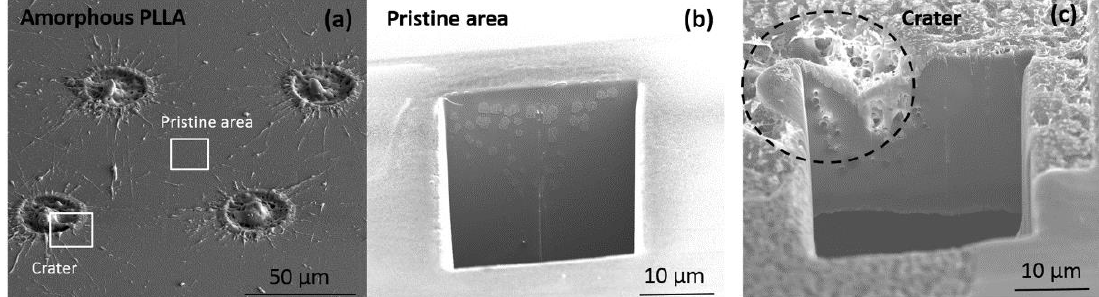
Figure 4. SEM images of craters produced by UV wavelength on amorphous PLLA; ( a ) and cross sections obtained by FIB on the non-ablated area (pristine, ( b )) and craters ( c ).